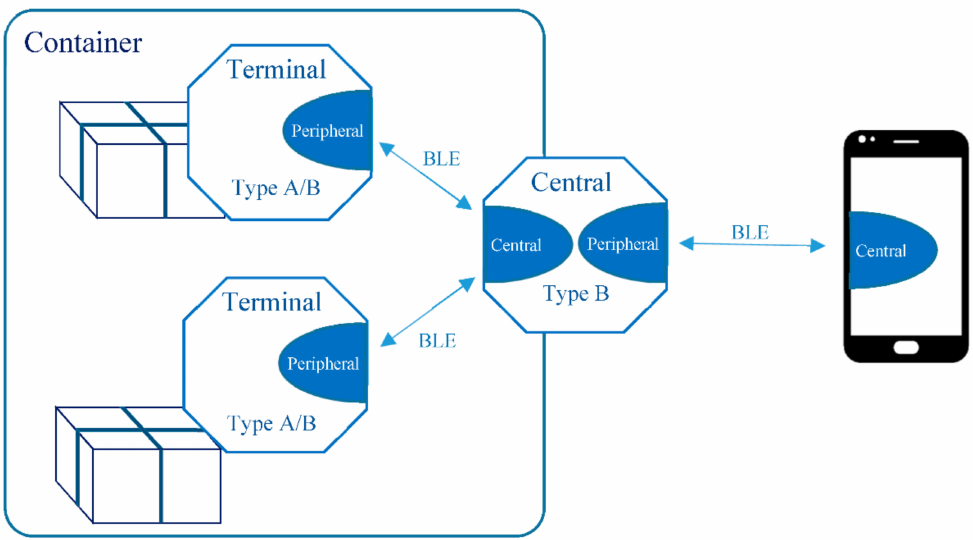
Figure 9. Type (C) topology using a B device as central node and A/B devices as